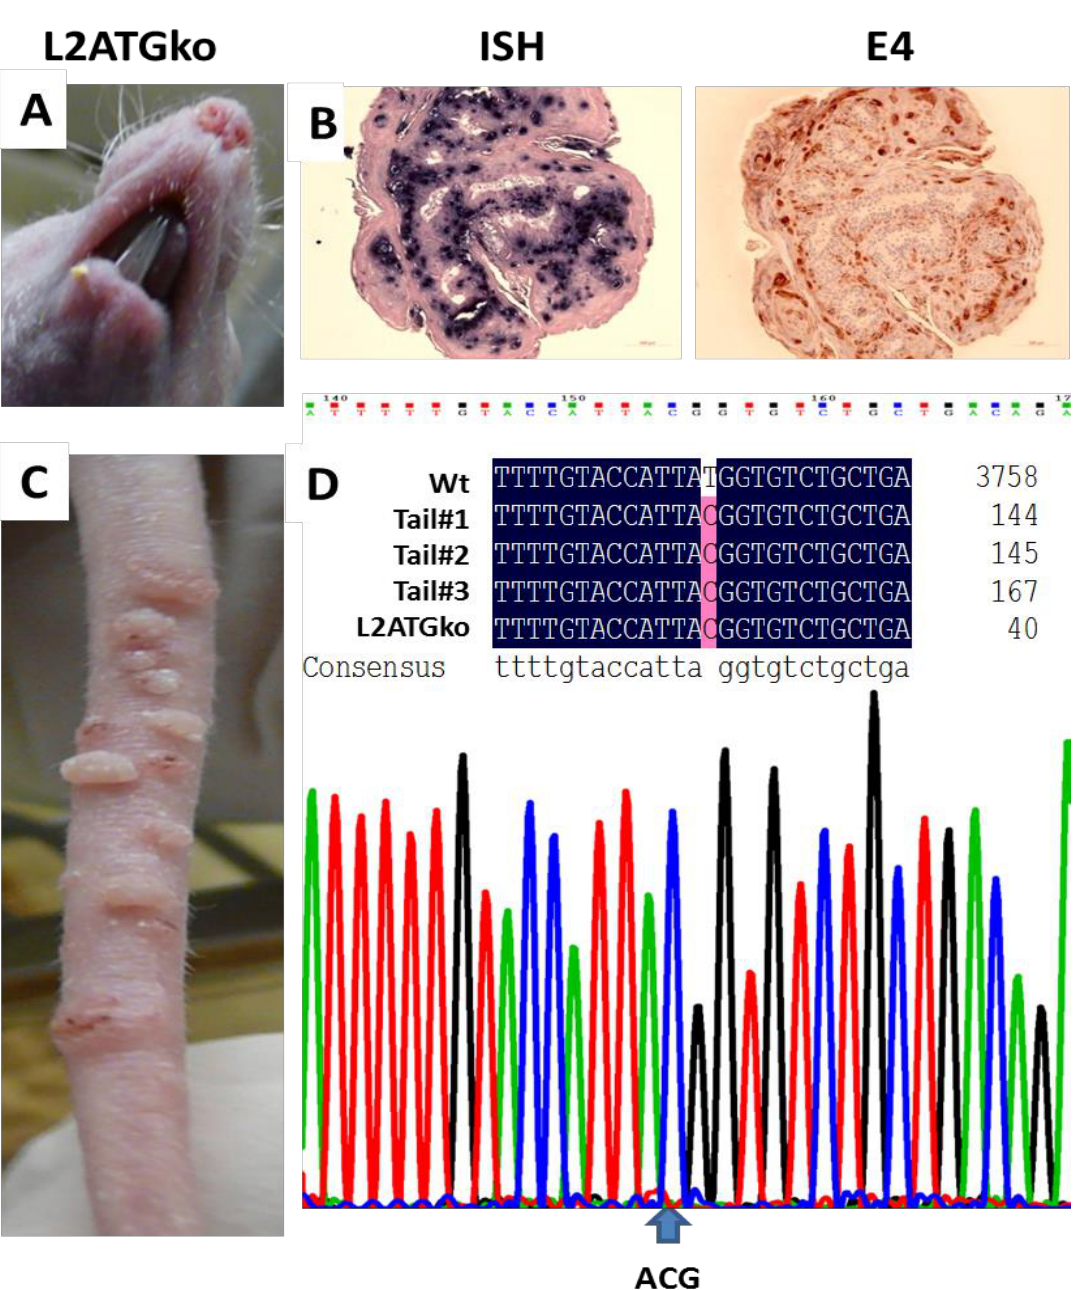
Figure 3. The L2ATGko mutant-induced tumor growth at tails of the nude mice. More tail lesions ( C ) than muzzle lesions ( A ) were detected. Viral DNA was detected in the suprabasilar epidermis of muzzle lesions by in situ hybridization (ISH), and viral E4 protein was detected in the same regions of the muzzle lesions by immunohistochemistry (IHC) ( B , 20 × ). DNA extracted from tail lesions induced by the L2 mutant maintained the ATG–ACG mutation. Input L2ATG mutant DNA was aligned with the amplified DNA from lesions ( D ).